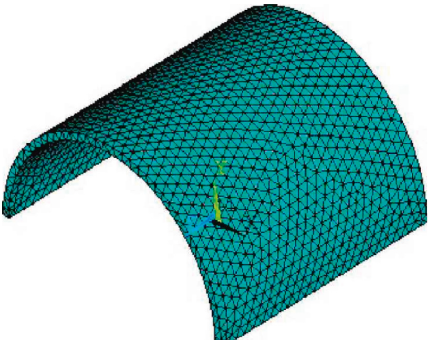
Figure 7: Grid of